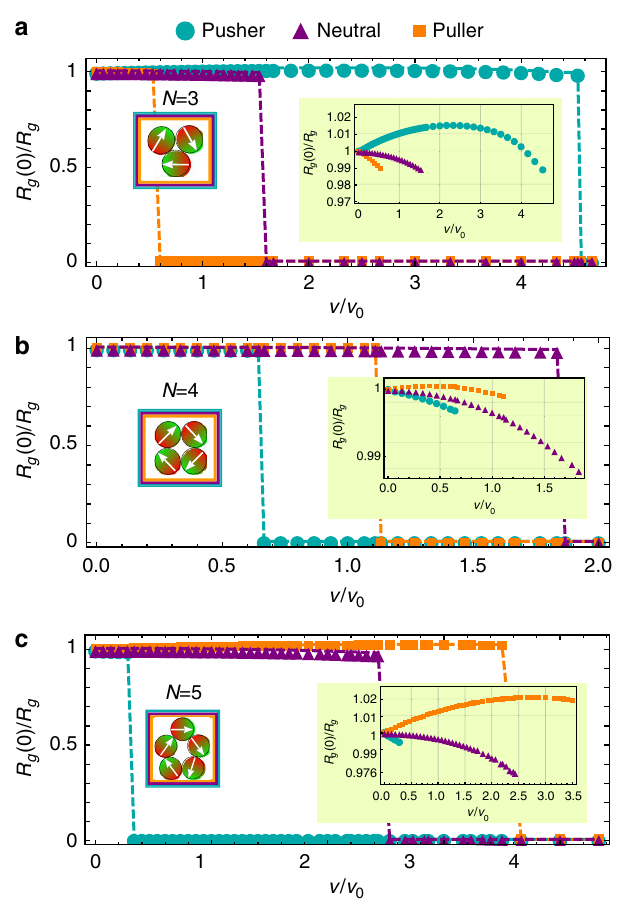
Figure 4 | Stability of microswimmer rings. Inverse radius of gyration R g (0)/ R g as a function of self-propulsion velocity v for ring-like clusters with a given number of swimmers: ( a ) N ¼ 3, ( b ) N ¼ 4 and ( c ) N ¼ 5. Insets: (right) close up the the radius of gyration and (left) sketches of the initial